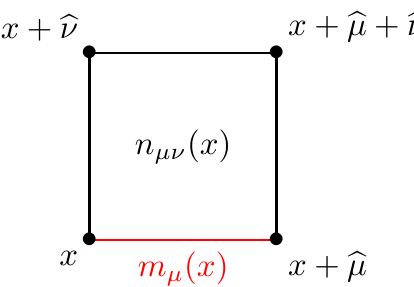
Figure 1 . Independent degrees of freedom are associated to links m µ ( x ) and faces n µν ( x ) . The latter should not be confused with plaquette observables f